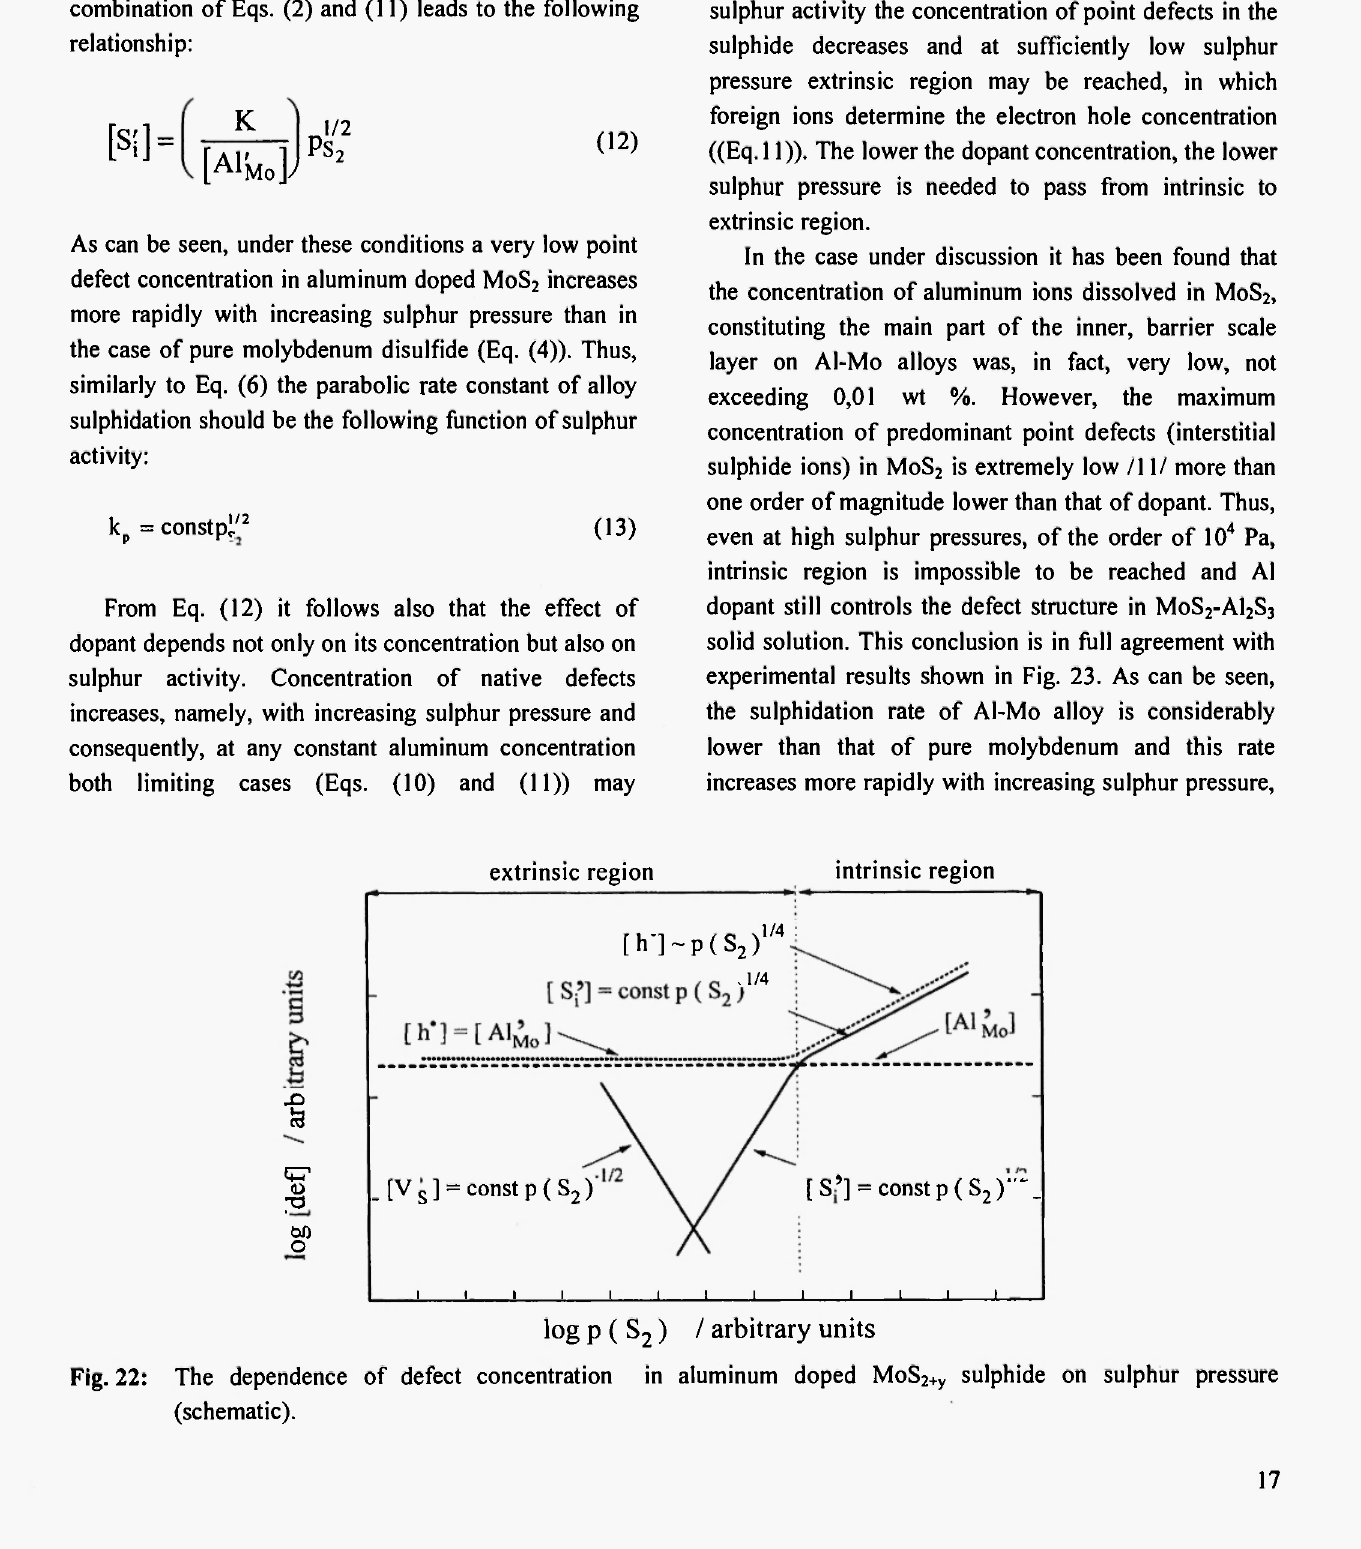
Fig. 22: The dependence of defect concentration in aluminum doped MoS 2+y sulphide on sulphur pressure